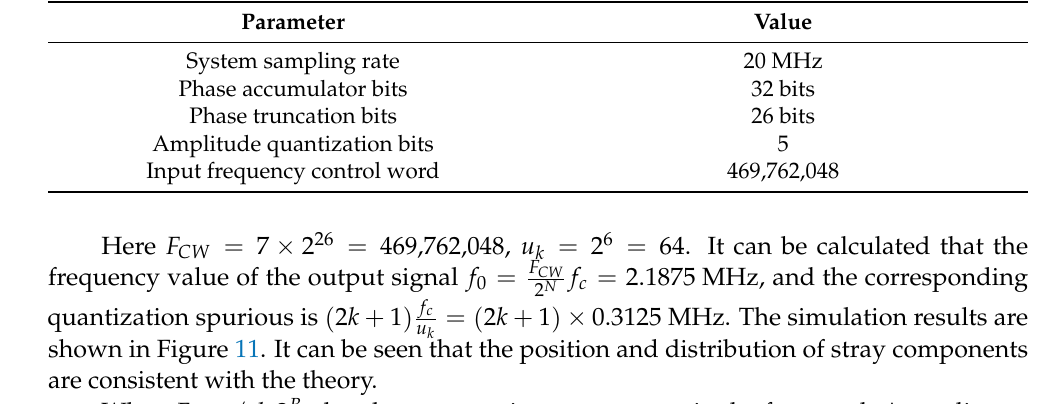
Table 3. Parameter of direct digital